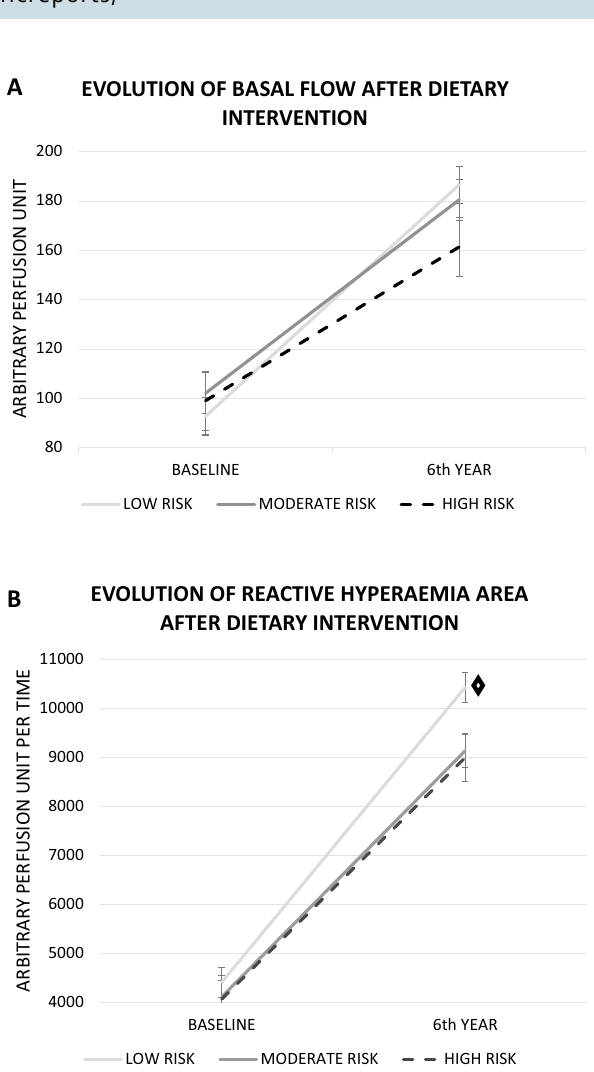
Figure 3. LASER DOPPLER FLOWMETRY (LDF). ( A ) Basal flow at baseline and after 6 years according to TRS2P risk groups. ( B ) Hyperaemia area at baseline and after 6 years according to TRS2P risk groups. ◊ indicates significant differences between low-risk versus moderate- and high-risk groups ( p <